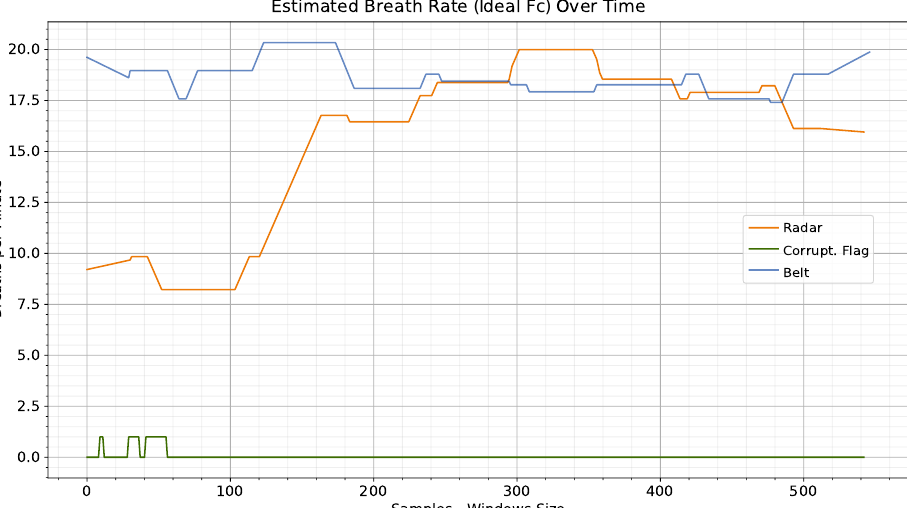
Figure 9. Comparison of instantaneous bpm between respiration belt and radar (with ideal Fc ) for a recording session. The x-axis corresponds to the difference between the number of frames in the session and the sliding window length. The radar signal corruption flag variable is plotted in green. At the beginning of the session, the radar signal is motion-corrupted (as shown in Figure 8) and thus does not lead to a reliable bpm. On the other hand, for the workplace use case, the reference belt signal is more robust to motion. In this case, the motion performed was the movement of the hands toward the